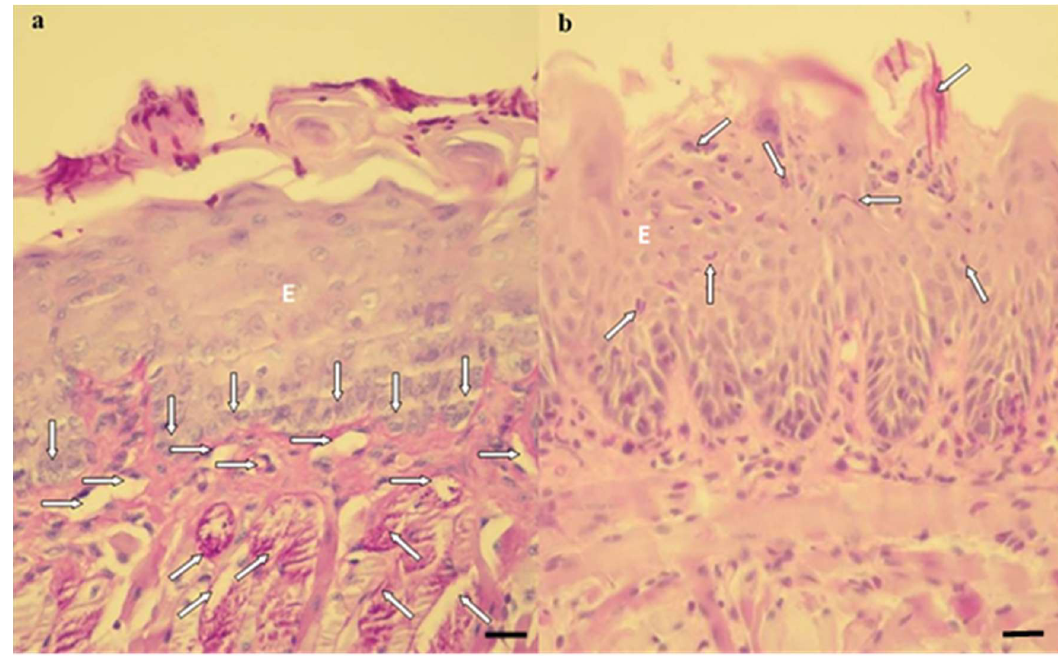
Figure 6. Histological sections showing an intense inflammatory reaction in the P-L-, P + L- and P-L + groups ( a ) and a mild inflammatory reaction in the P + L + , NYS, P + L + NYS and NYS + P + L + groups ( b ). ( a ) The cells of the basal layer of the epithelium (vertical arrows) with a thin lamina propria, present a mild inflammation. There was a predominance of mononuclear cells in the middle of a dilated blood vessel (horizontal arrows). The presence of hyphae, pseudohyphaes, and blastopores can be observed in the middle of the keratin layer, and the superficial muscular tissue was degraded (oblique arrows) (PAS-H 250x). ( b ) The keratin layer with a varying thickness and the presence of hyphae, pseudohyphaes, and high blastopore (arrows), covering the epithelial tissue (E) as well as an intact basal layer should be noted. This epithelium presents characteristics of acanthosis and does not exhibit defined lingual papillae. All these events were observed after 7 days of treatment (PAS-H 250x). Scale bar: 20 µm